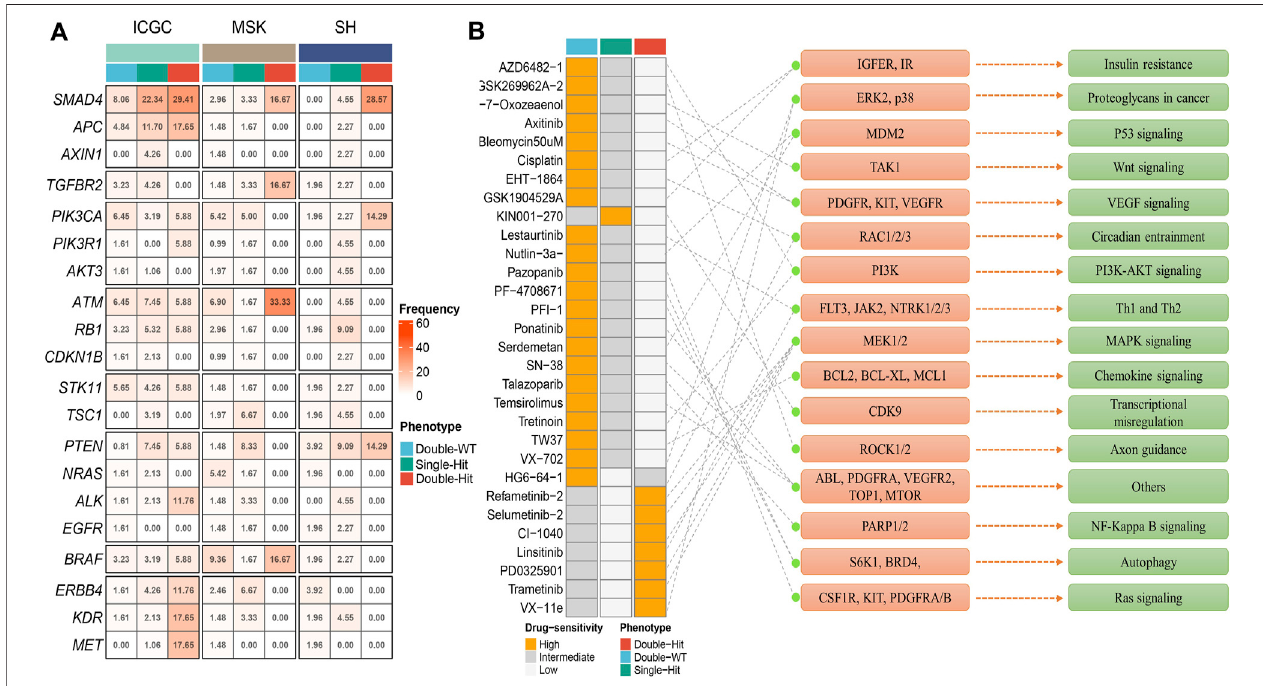
FIGURE5| Molecularandpharmacologicallandscapeofthreemutantphenotypes. (A) Mutationrateofdrivergenesamongthreemutationphenotypesinthethree cohorts. (B) 30potentialchemotherapydrugswithspeci fi csensitivitytoeachphenotypewereidenti fi edintotal.Theleftpanelrepresentsthedrugnamesandthelevelof sensitivity in each phenotype, the middle panel represents the drug-targeted molecules, and the right panel represents the drug-targeted pathways.